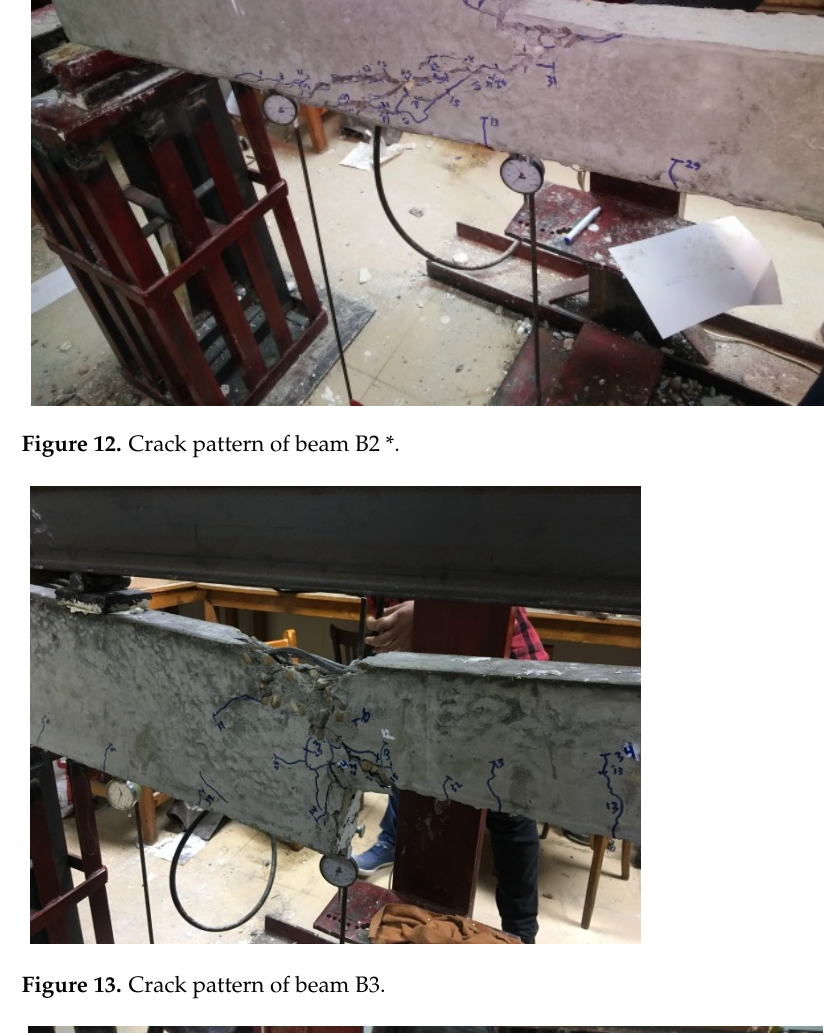
Figure 13. Crack pattern of beam B3.